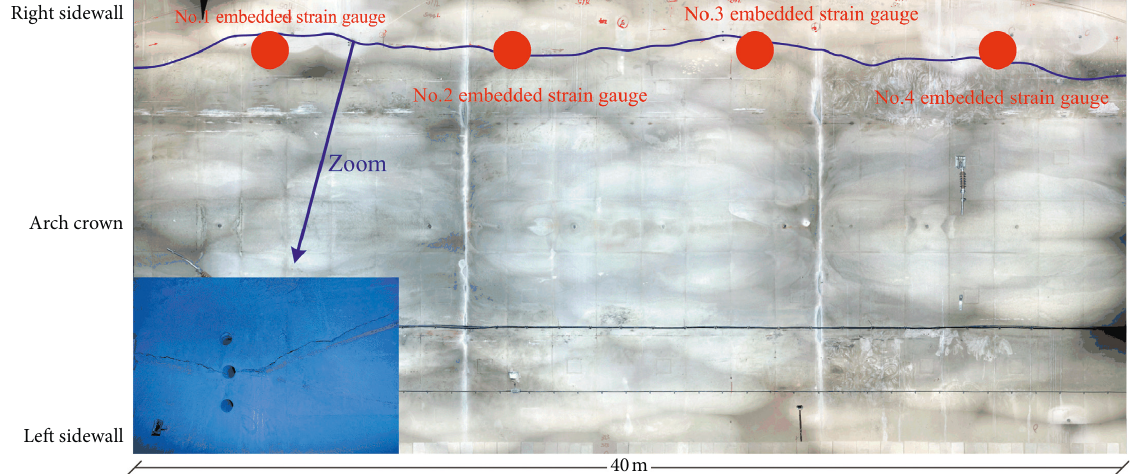
Figure 3: Lining cracking in field.